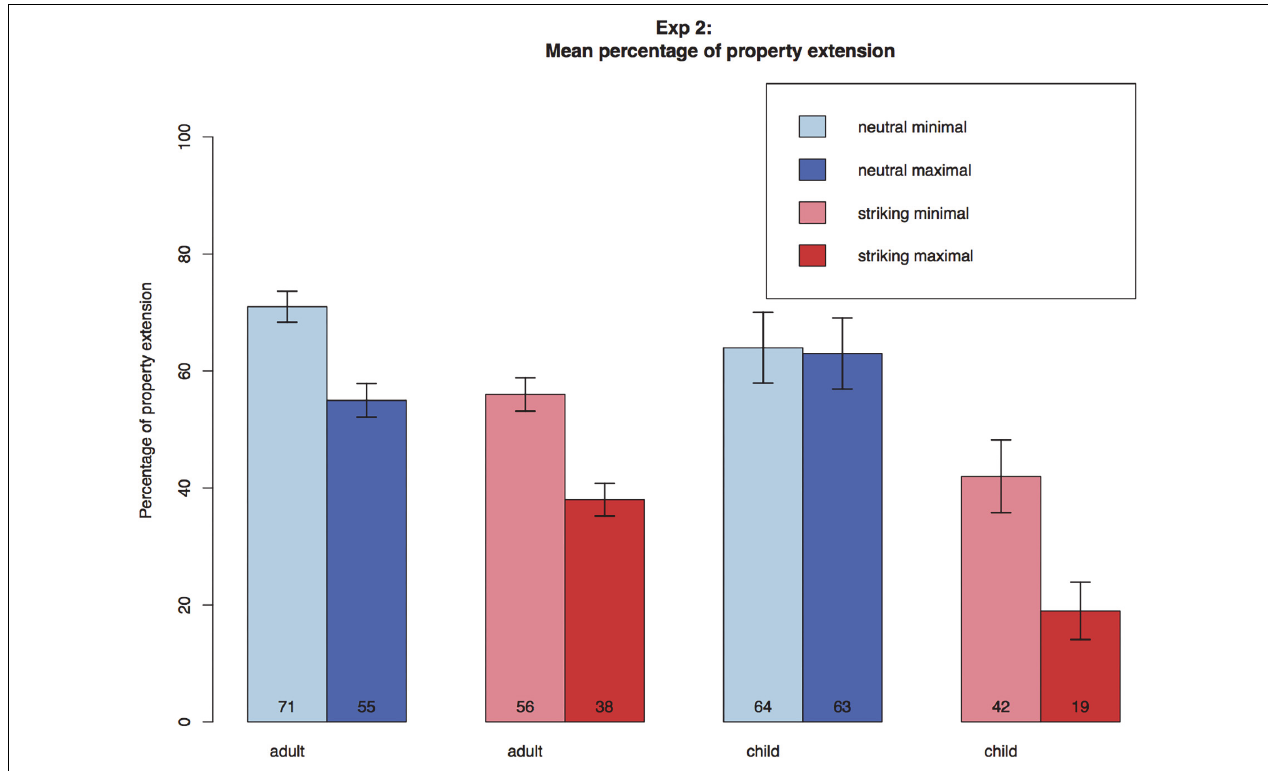
FIGURE 3 | Mean percentage of property extension across conditions in Experiment 2. Error bars represent standard